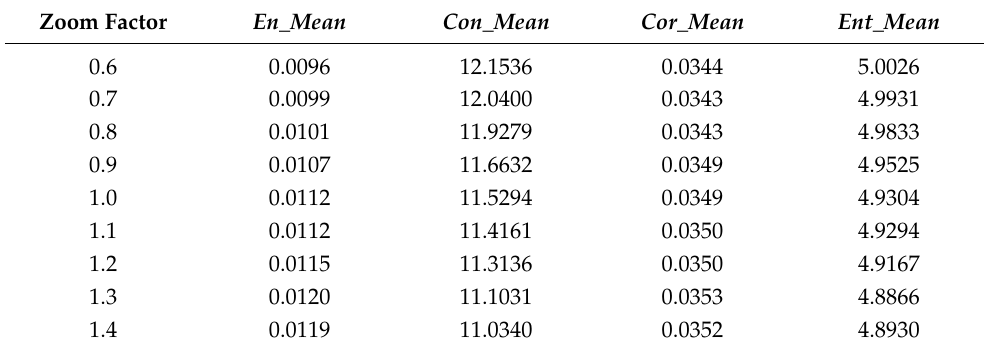
Table 11. Results of EGLCM with different zoom factors.